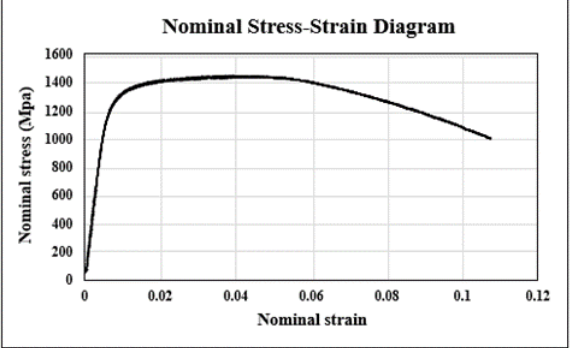
Figure 10. Nominal stress–strain graph of SKD61.